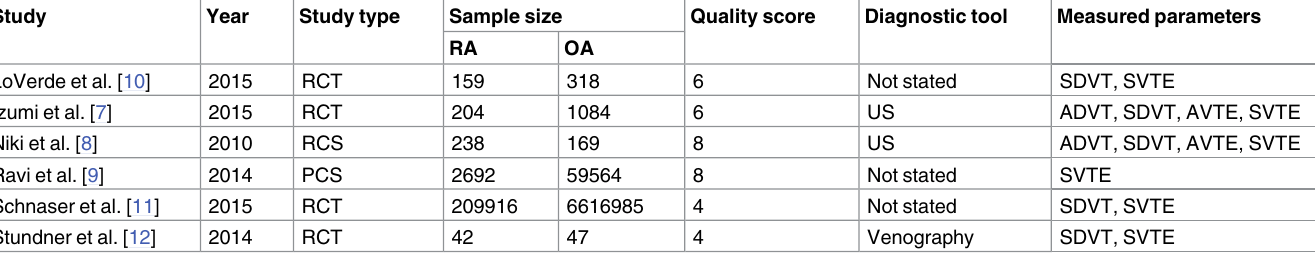
Fig 1. PRISMA (PreferredReporting Items for Systematic reviews and Meta-analyses) flow diagram of the identification and selection of the studies included in this meta-analysis. doi:10.1371/journal.pone.0166844.g001 factors. Of the six studies, four were assessed as being of high quality (Newcastle-Ottawa Scale (cid:21) 5, Table 1) Deep vein thrombosis Of the six studies, two compared rates of asymptomatic and symptomatic DVT, and four compared rates of symptomatic DVT after primary TKA in patients with RA and OA. The Table 1. Characteristics of the studies included in the